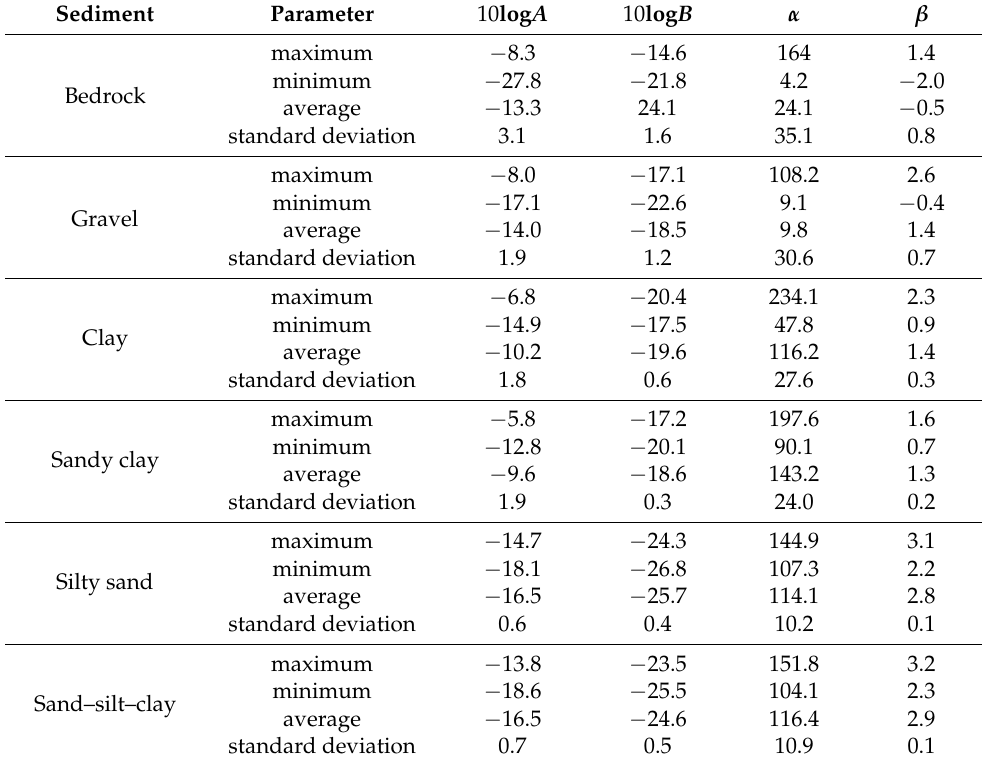
Figure 7. The angular response curves corresponding to different sediment types: ( a ) bedrock; ( b ) gravel; ( c ) clay; ( d ) sandy clay; ( e ) silty sand; ( f ) sand–silt–clay. Table 2. Statistical of characteristic parameters for inhomogeneous seafloor.